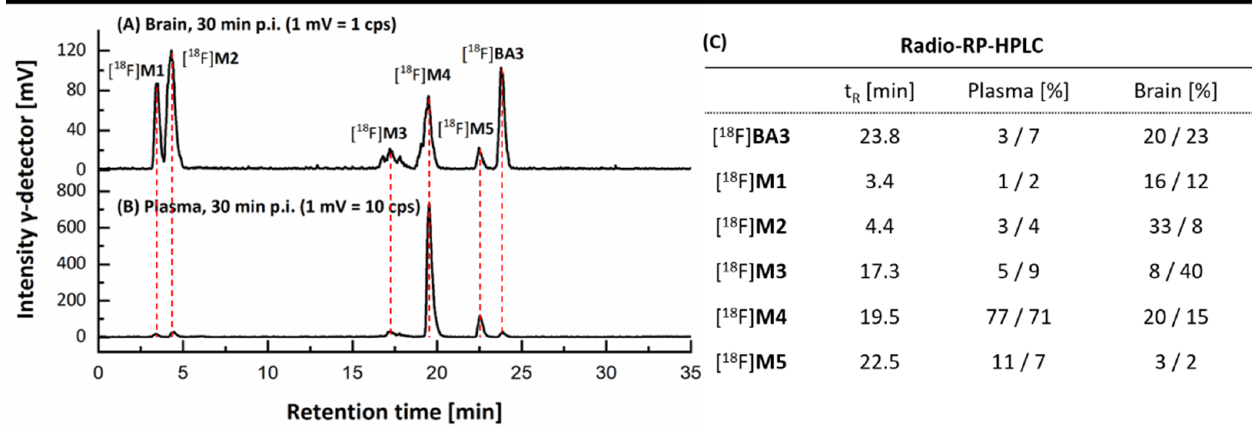
Figure 4. ( A , B ) Representative radio-RP-HPLC chromatograms of in vivo metabolism studies from brain and plasma samples obtained 30 min p.i. of [ 18 F] BA3 in a CD-1 mouse ([ 18 F] M1 -[ 18 F] M5 : radiometabolites detected in brain; gamma-detection via radio-RP-HPLC: ReproSil-Pur 120 C18-AQ column (250 × 4.6 mm, 5 µm), Gradient MeCN/20 mM NH 4 OAc aq. (see quality control), flow: 1 mL/min) and ( C ) the amount of radiometabolites in percent ( n = 2).